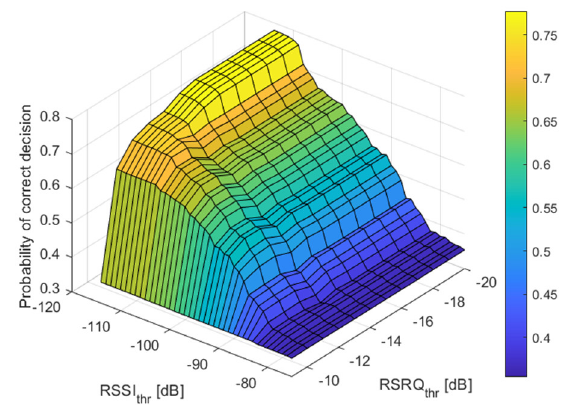
Figure 7. The probability of false positive decision for different threshold values for RSRP and SINR while the threshold for RSRQ was set to −20 dB and the threshold for RSSI was set to −114 dB.